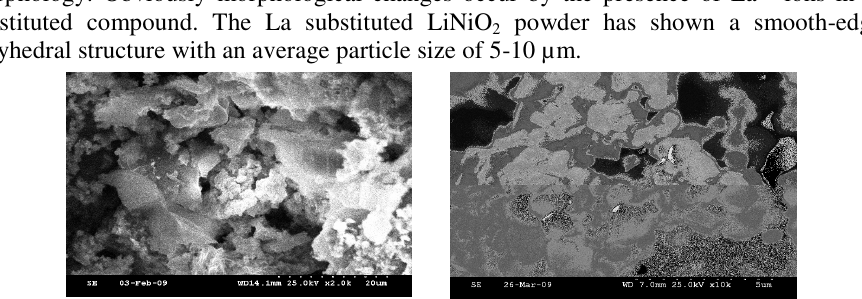
Figuree 4b. SEM micrograph of LiNi La O 0.75 0.25